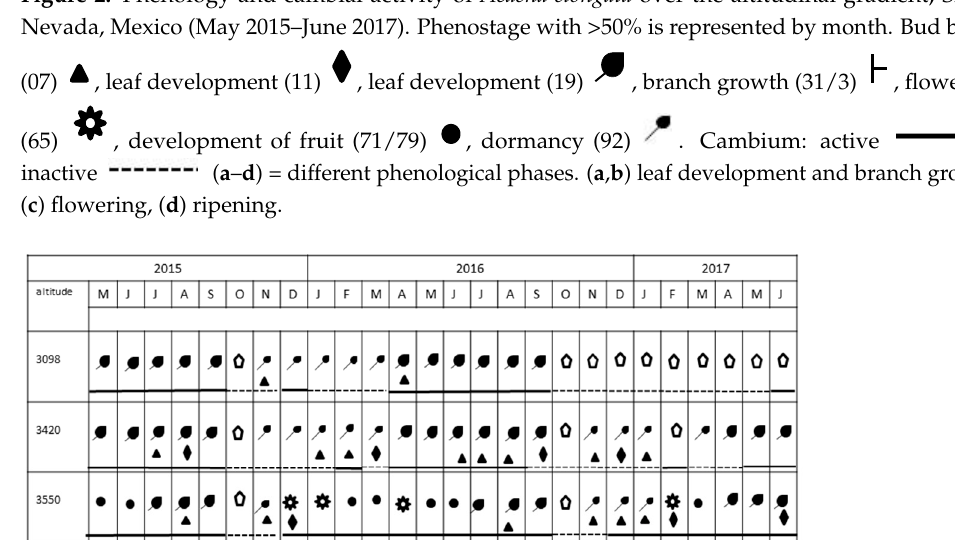
Figure 2. Phenology and cambial activity of Acaena elongata over the altitudinal gradient, Sierra